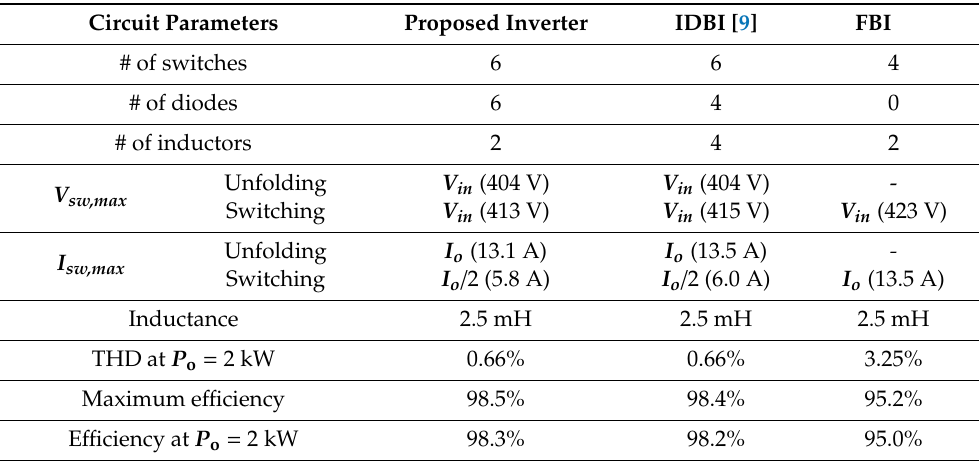
Table 4. Circuit parameters and experimental results for experimental inverters. Parenthesis contain peak switch voltages and currents measured at V in = 404